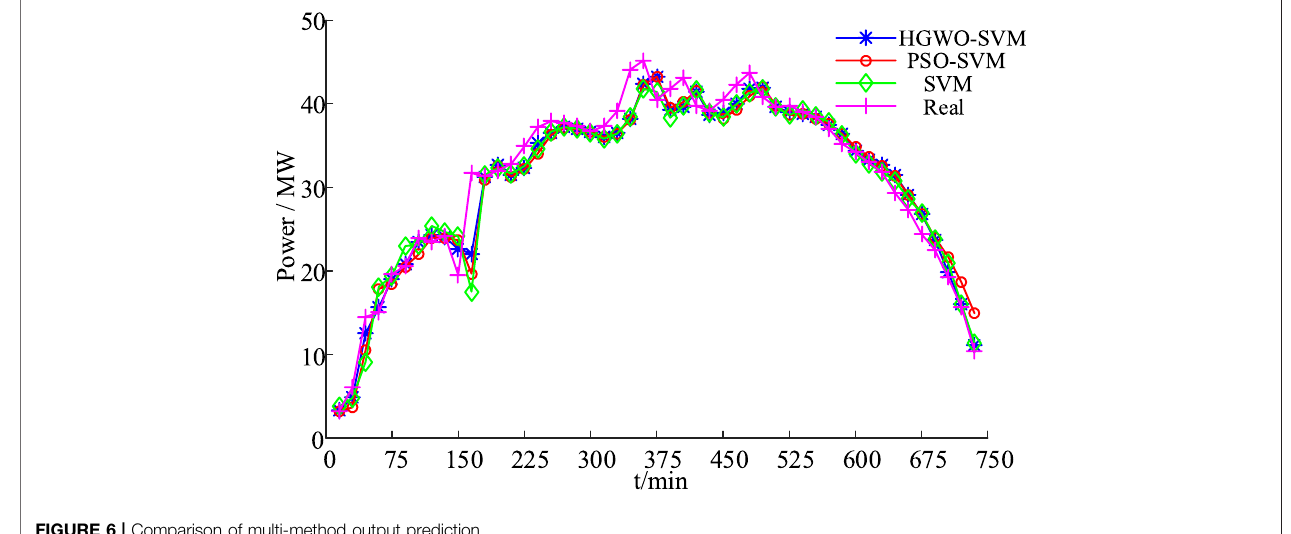
FIGURE 6 | Comparison of multi-method output prediction.